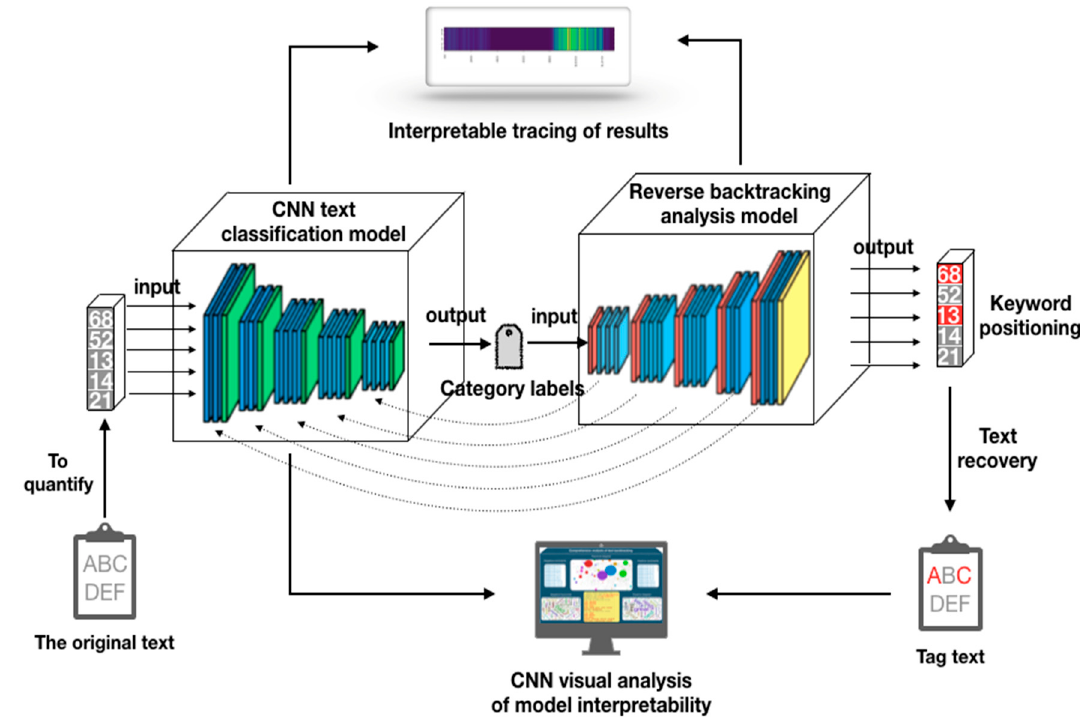
Figure 1. Analysis method of model interpretability.